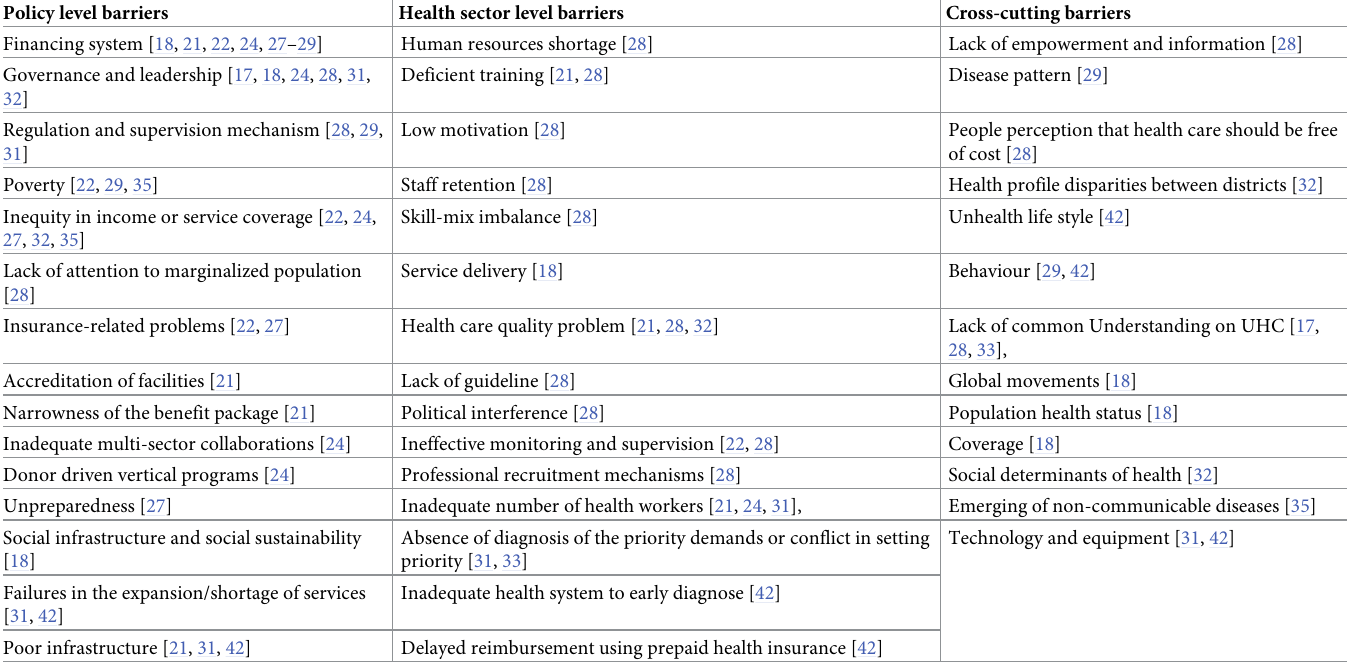
Table 3. Policy, health sector and cross-cutting barriers of